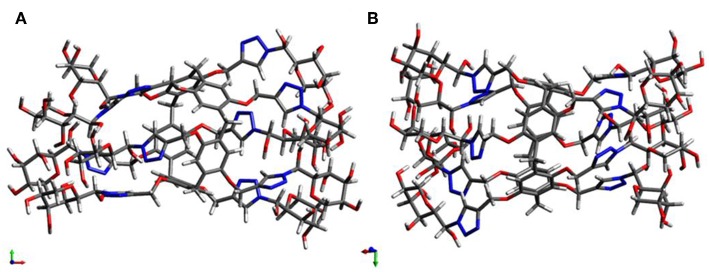
Optimized structure: (A) (Sp-D)-GP5 and (B) (Rp-D)-GP5.